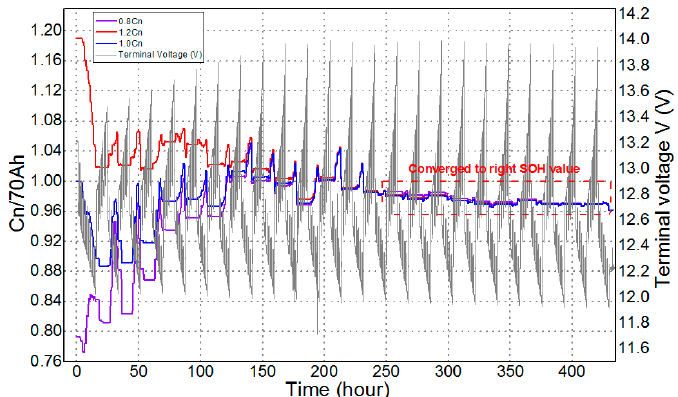
Figure 6. The convergence of the SOH estimation result with different initial capacity values (The measured capacity of the battery is 98%